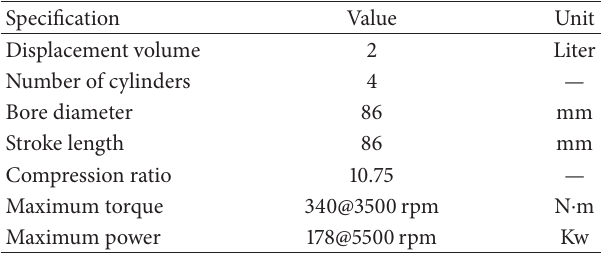
Table 1: Engine specifications.